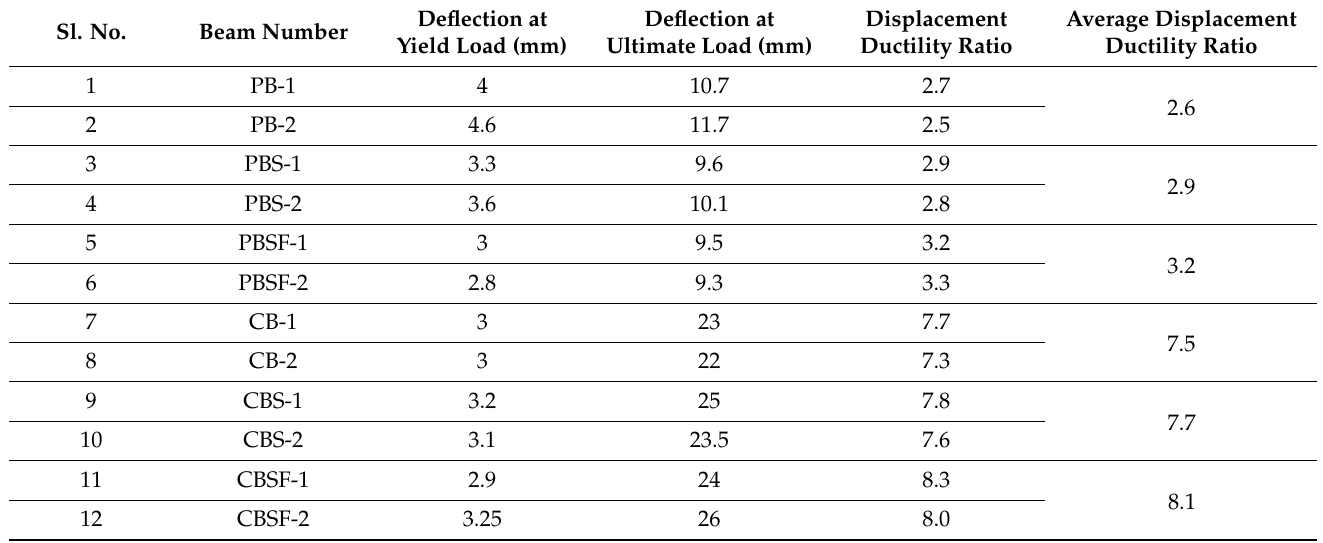
Table 3. Ductility values of CFS beams.